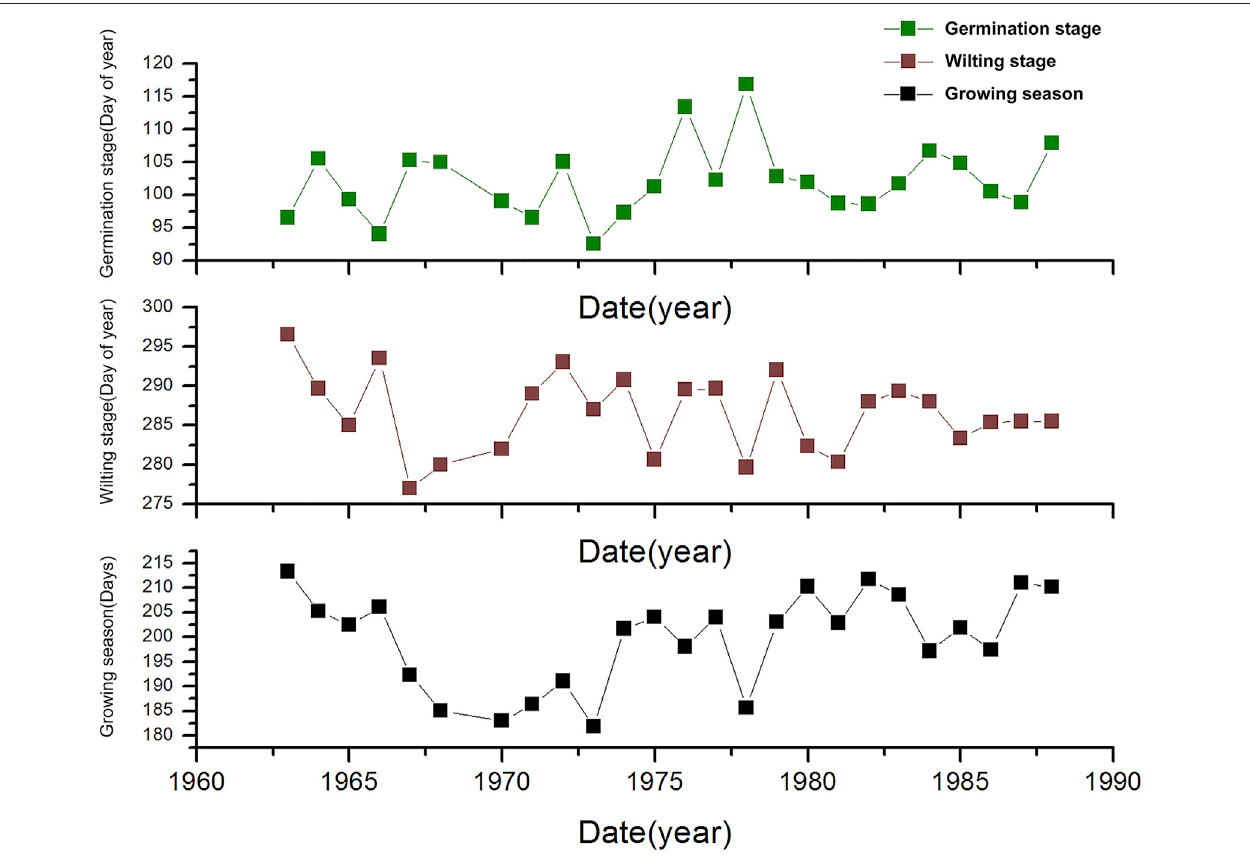
FIGURE 4 | The temporal dynamics of the phenological period at the study sites (1963 – 1988). The green line is the inter-annual variation in the germination stage; the brown broken line shows the inter-annual variation in the wilting stage, and the black broken line shows the inter-annual variation in the length of the growing